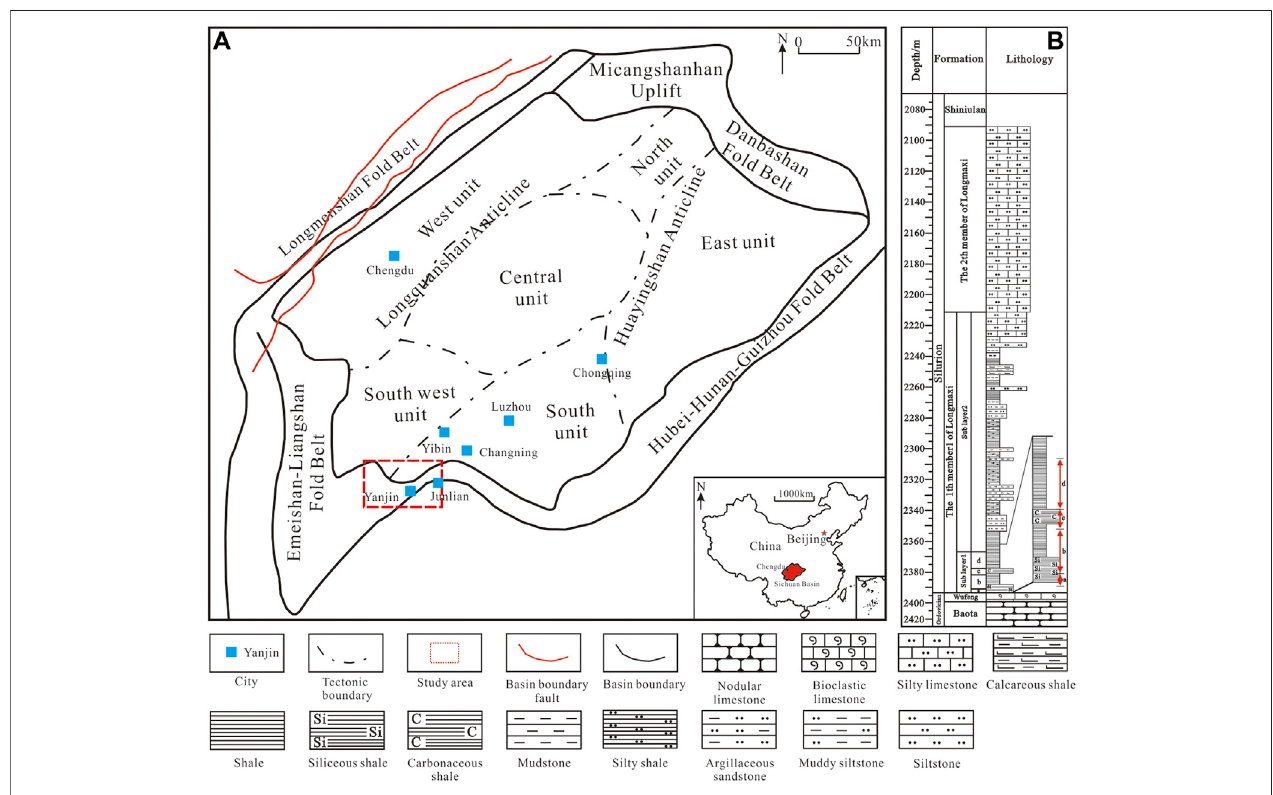
FIGURE 1 | Geological overview of the Yanjin – Junlian area (Zhang et al., 2021). (A) . Structural location; (B) . stratigraphic histogram.